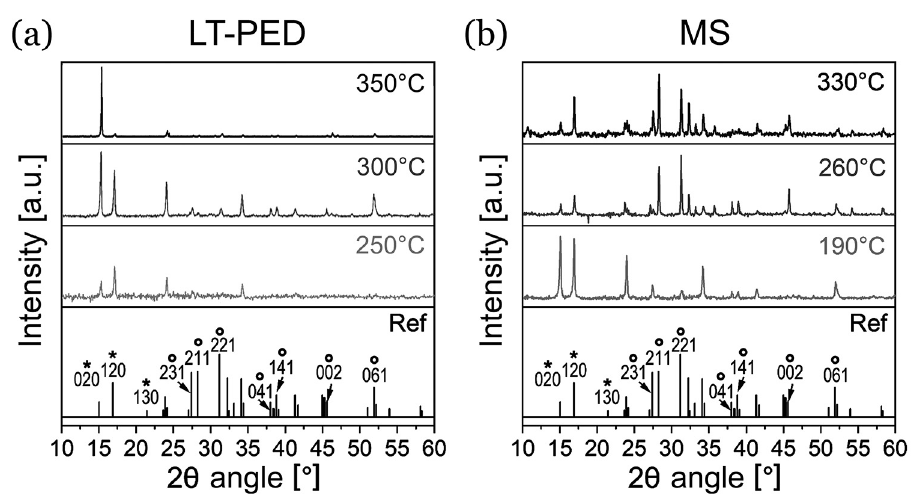
Fig. 2. – X-ray diffraction patterns of Sb 2 Se 3 films deposited at different temperatures on bare glass substrates: (a) by LT-PED; (b) by MS. JPCDS 15–0681 reference is reported at the bottom, where a few selected reflections are highlighted with * symbol, if related to ribbons laying parallel to the substrates, or with ◦ symbol, if related to ribbons with an orientation having a non-zero perpendicular component ( hkl with l (cid:3) =